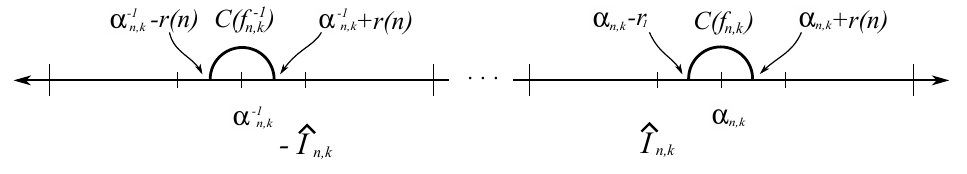
Figure 10: Half circles C ( f n , k ) and C ( f −1